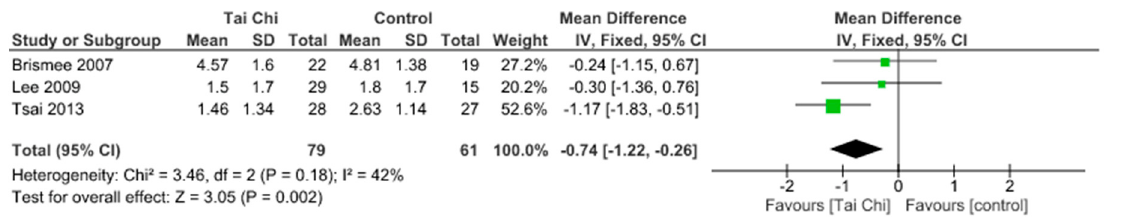
Figure 16. Sti ff ness: Land-based exercise versus Control.